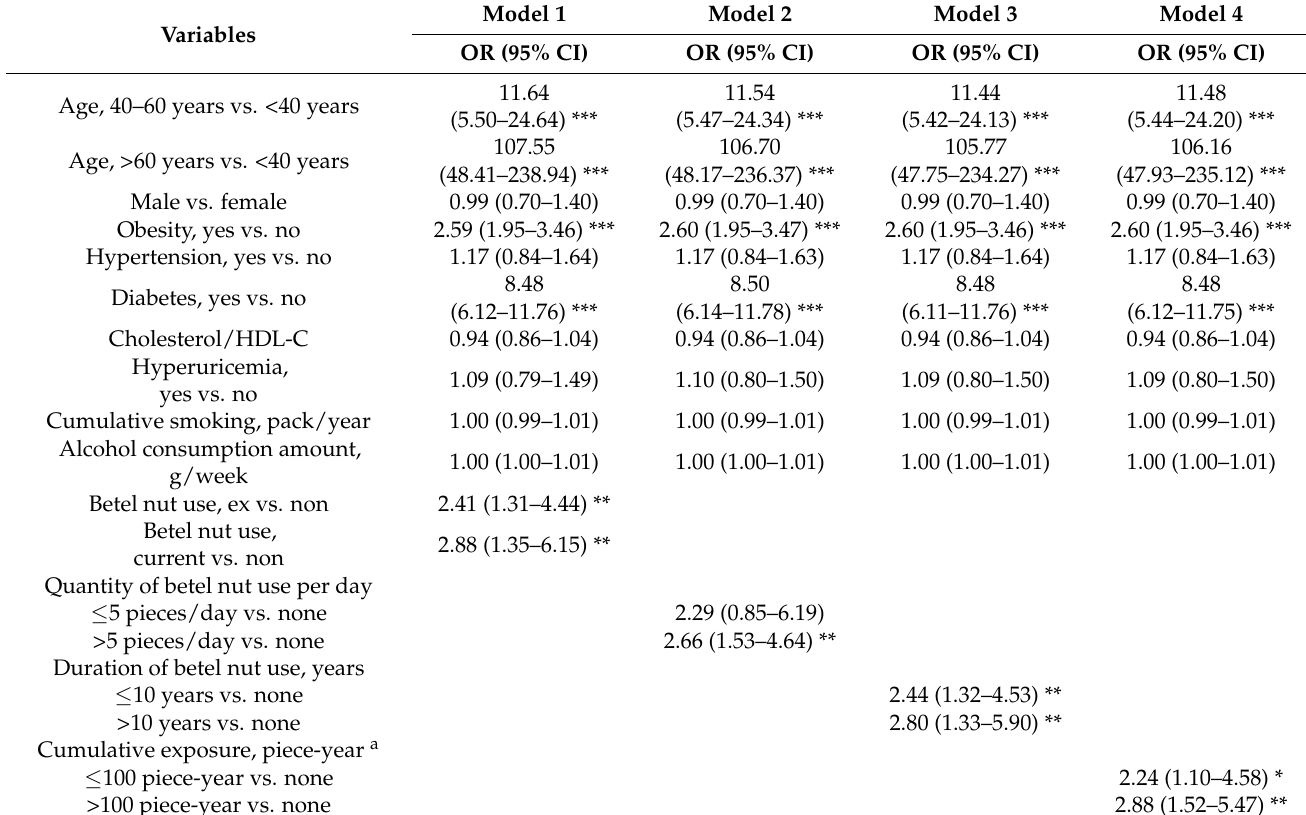
Table 4. Logistic regression model for significant liver fibrosis (NFS ≥ − 1.455) and betel nut chewing among patients with